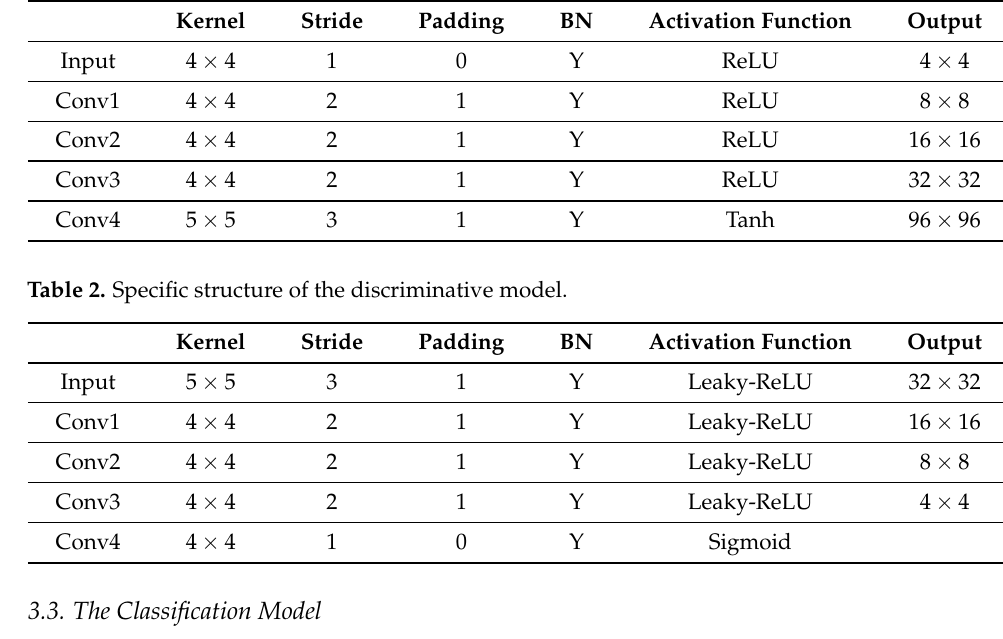
Table 1. Specific structure of the generative model.